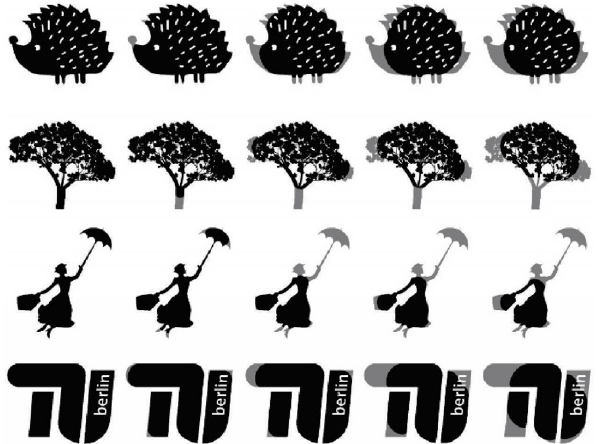
Fig. 6 Decreasing contact areas during the detachment process for a series of flat-ended indenters.